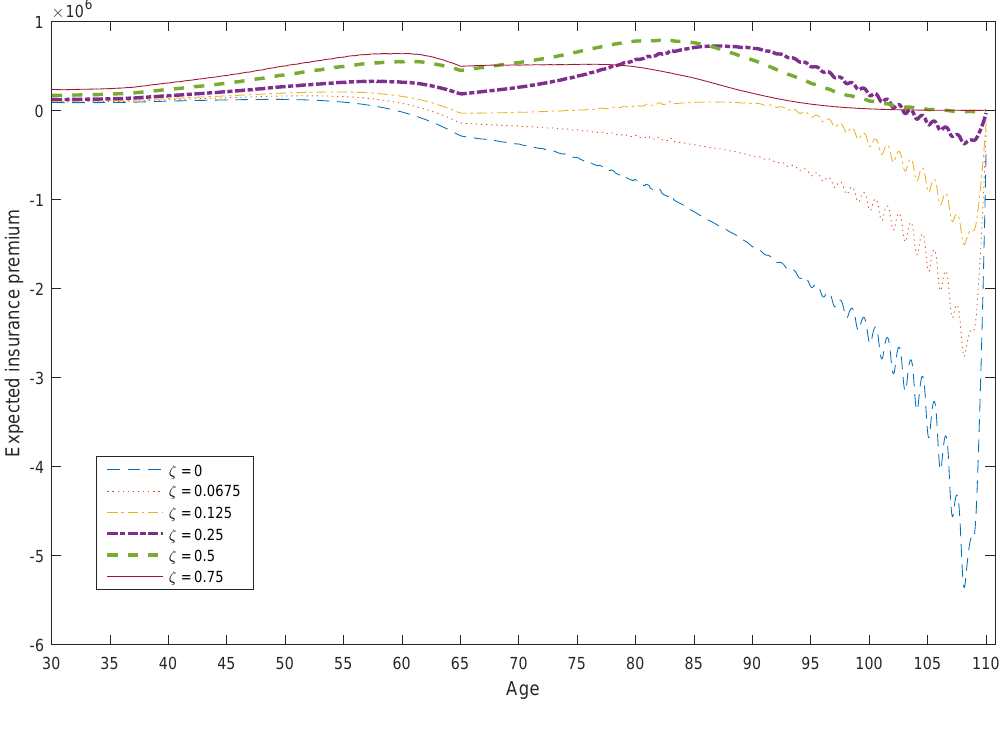
Figure 2. Expected insurance premium for different ζ